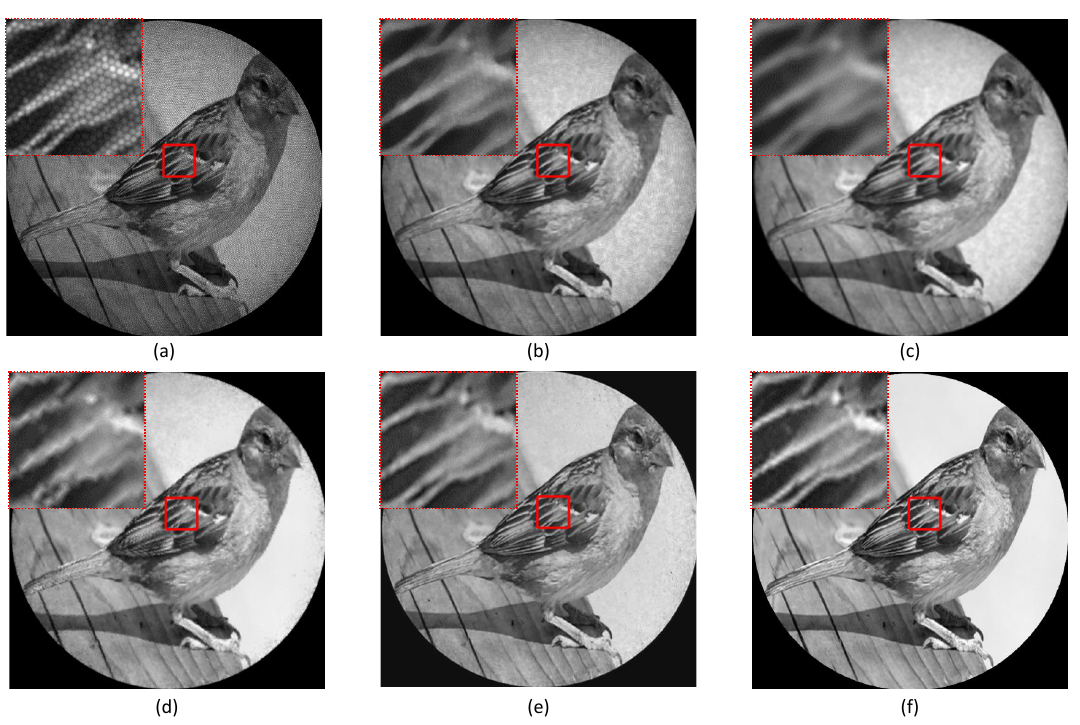
Figure 5. Honeycomb artifact removal with various methods. ( a ) Synthetic fiber bundle image (raw), ( b ) median filter, ( c ) Gaussian filter, ( d ) interpolation, ( e ) HAR-CNN, and ( f ) ground truth